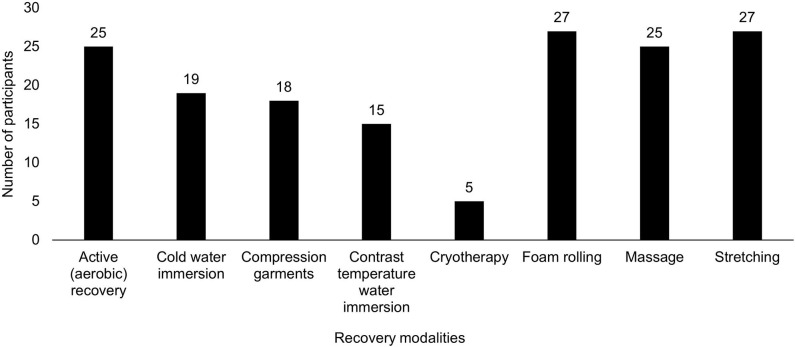
Recovery modalities.